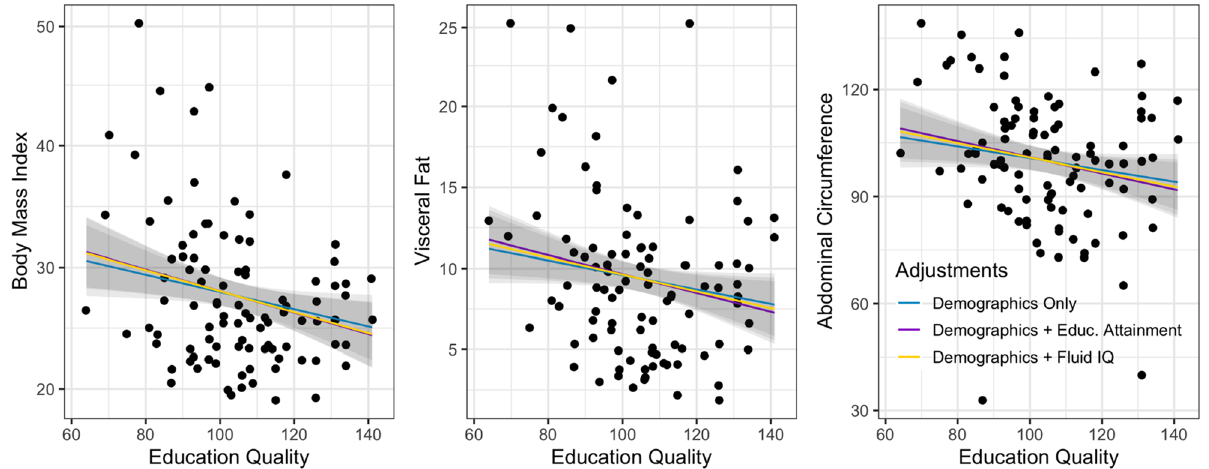
Figure 1. Associations between educational quality and BMI, visceral fat, and waist circumference. The blue line is the association between educational quality and the outcome adjusting for demographics (age, sex, ethnoracial category). The purple line further adjusts for educational attainment as measured by educational attainment. The yellow line further adjusts for fluid IQ. The strength of the association between educational quality and outcomes is virtually unchanged after adjustment for demographics, educational attainment, or fluid IQ.